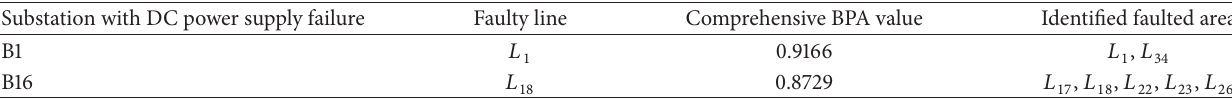
Table 10: WABP performance under condition of DC power supply